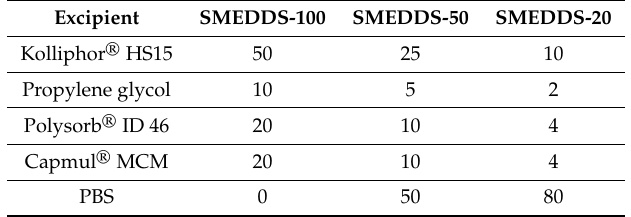
Table 2. Composition of selected formulation SMEDDS-100, SMEDDS-50 and SMEDDS-20.